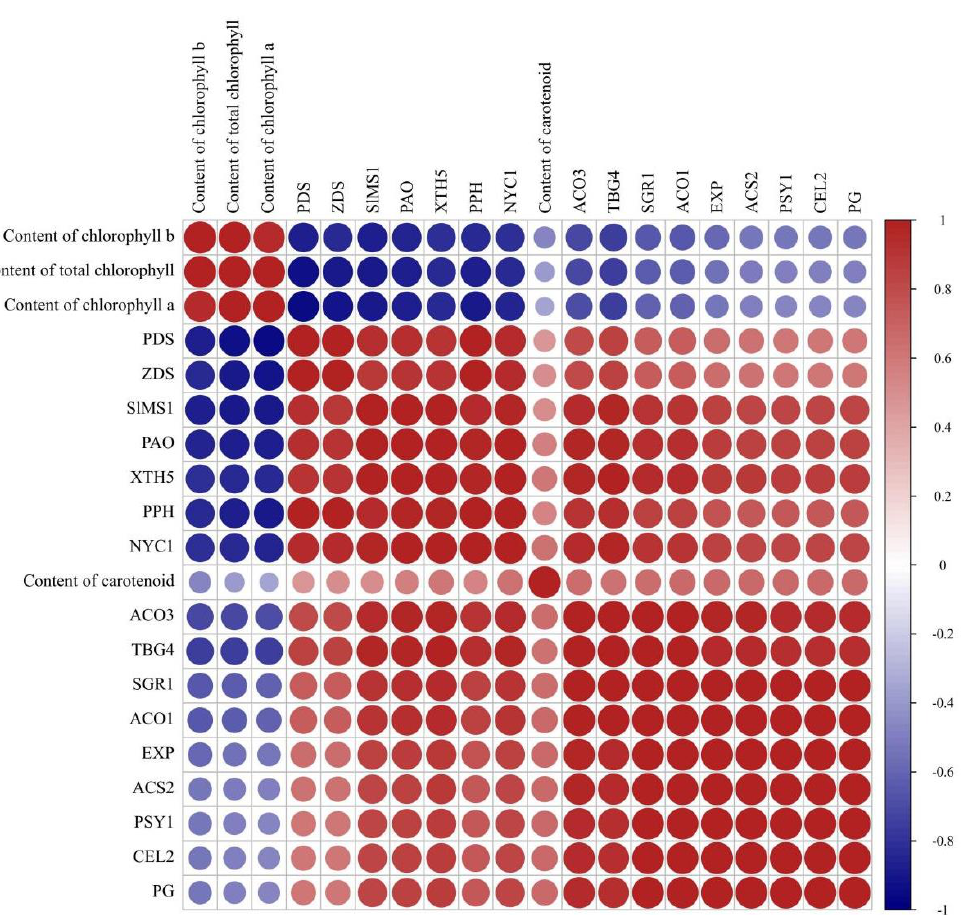
Figure 9. Correlation analysis of the parameters of chlorophyll, chlorophyll a, chlorophyll b, carotenoid, gene expressions of NYC1, PAO, PPH, SGR1, PSY1, PDS, ZDS, ACS2, ACO1, ACO3, SlMS1, PG, XTH5, TBG4, EXP and CEL2 based on the data in control (TRV) and SlMS1 -silenced fruit (TRV- SlMS1 ) at 21 and 27 days post inoculation and in control (pSAK277) and SlMS1 -overexpressed (pSAK277- SlMS1 ) fruit at 10 days post inoculation.